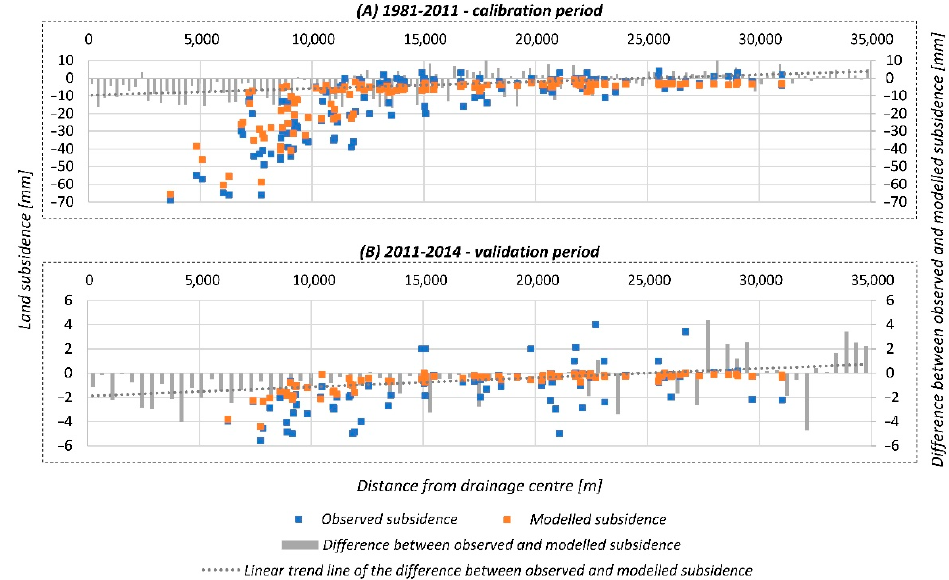
Figure 8. The observed and modelled value of mining-induced drainage related land subsidence as a distance from the drainage center for ( A ) calibration and ( B ) validation